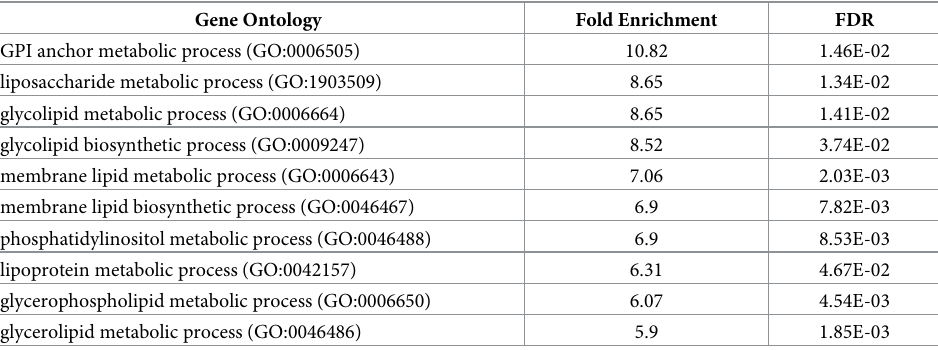
Table 5. Gene ontology analysis of candidate genes from the ConA screen. Gene Ontology Fold Enrichment